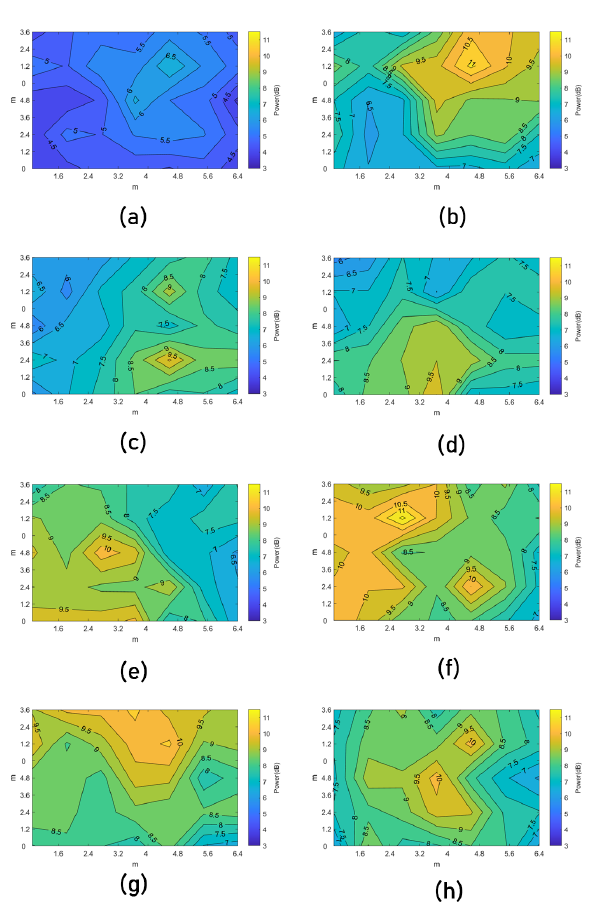
Figure 9. The distribution of 19Khz signal strength in the test area (a) The background noises (b) - (h) The signal from the No.1- No.7